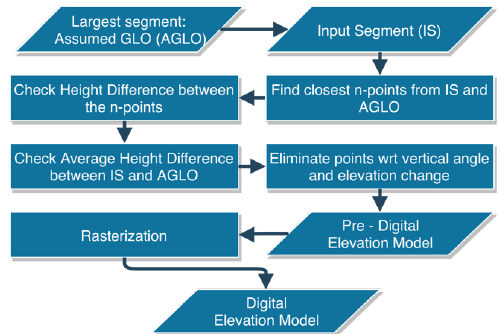
Figure 11. DEM extraction from segmented point clouds.